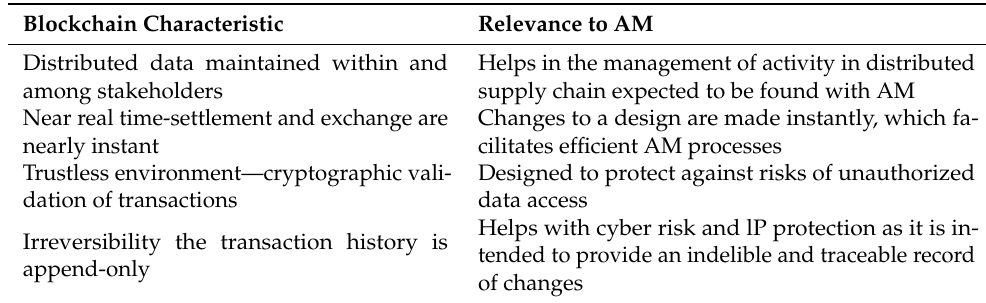
Table 2. Blockchain characteristics and their relevance to